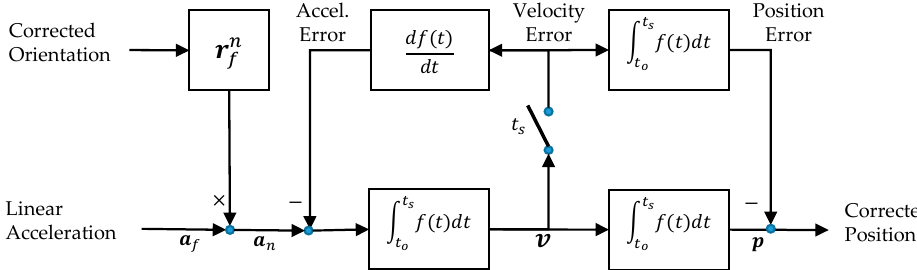
Figure 3. The accelerometer measurements are resolved in the world coordinate frame using the corrected orientation. The resultant accelerations are integrated twice to determine velocity and position. During stationary periods t s , any remaining velocity is considered an error and its value is used to reset the position and acceleration errors.